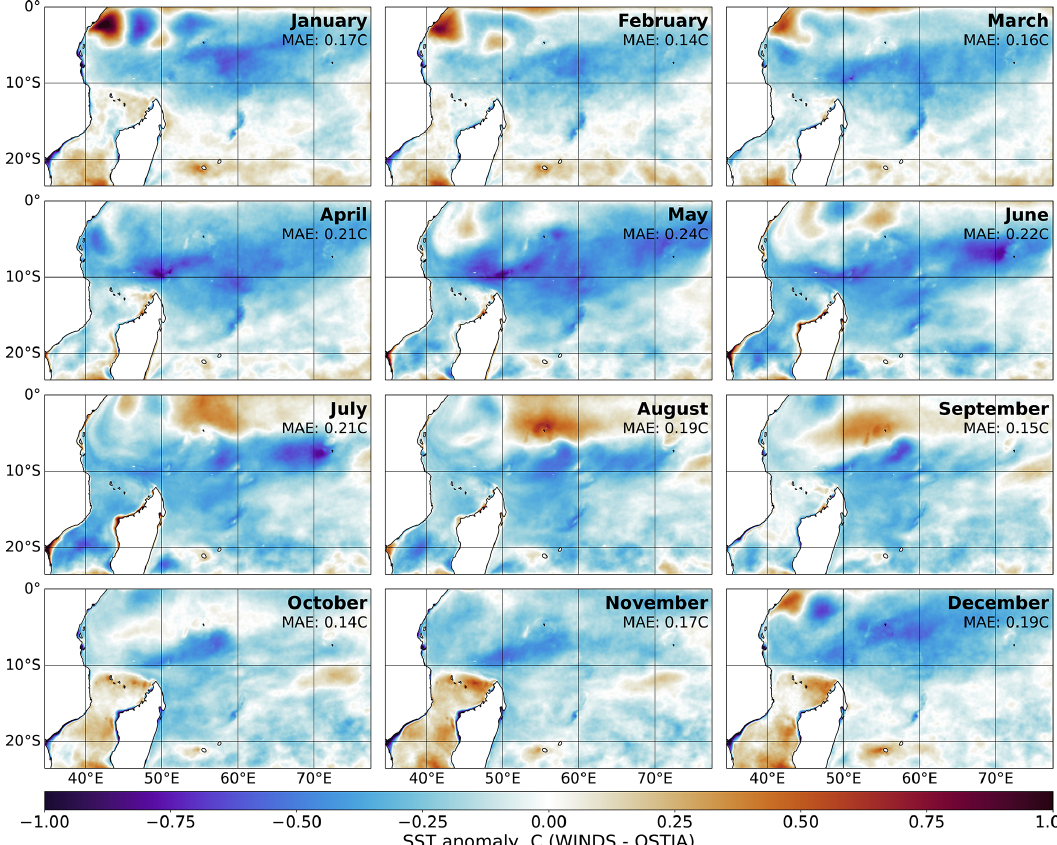
Figure 10. Difference between monthly climatological SST simulated by WINDS and satellite and in situ-derived sea-surface temperature (SST) estimates from the Operational Sea Surface Temperature and Sea Ice Analysis (OSTIA). Blues indicate that WINDS simulates cooler temperatures and reds indicate that WINDS is